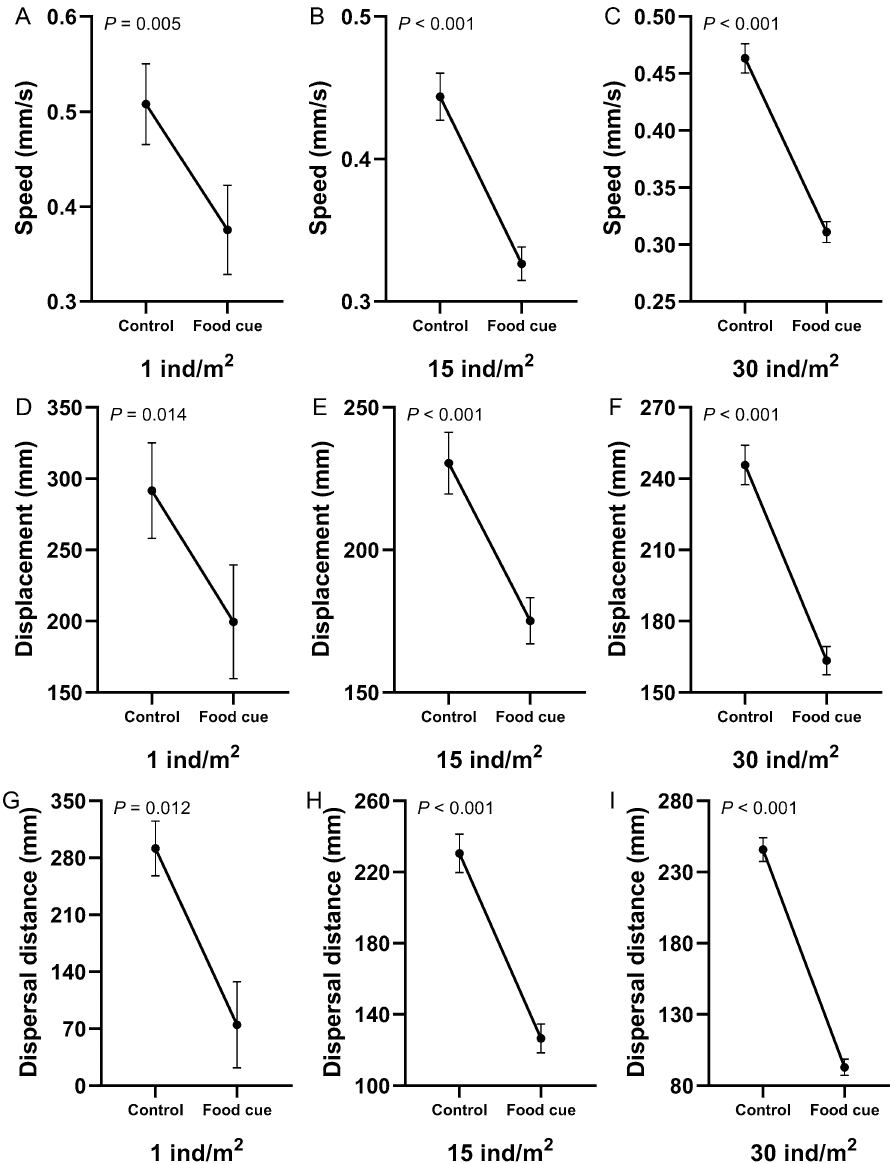
Figure 2. Behavioral changes (mean ± SEM) of individuals in response to the food cues. Movement speed of sea urchins without and with the food cues in the three density groups ( A – C ). Movement displacement of sea urchins with and without the food cues in the three density groups ( D – F ). Dispersal distance of sea urchins with and without the food cues in the three density groups ( G – I